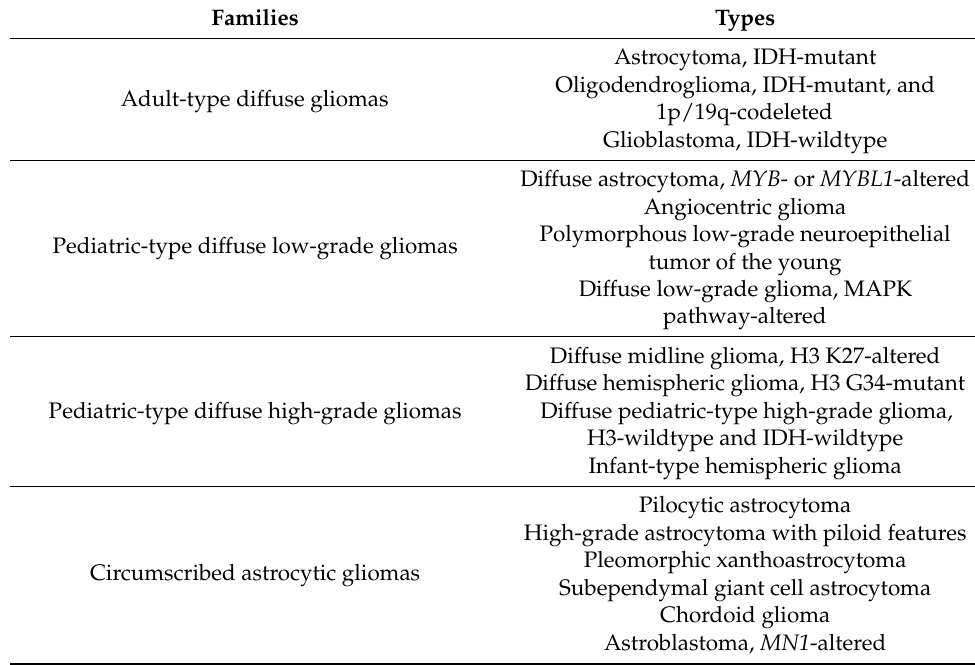
Table 1. Families and types of gliomas according to the 2021 World Health Organization Classification of Tumors of the Central Nervous System